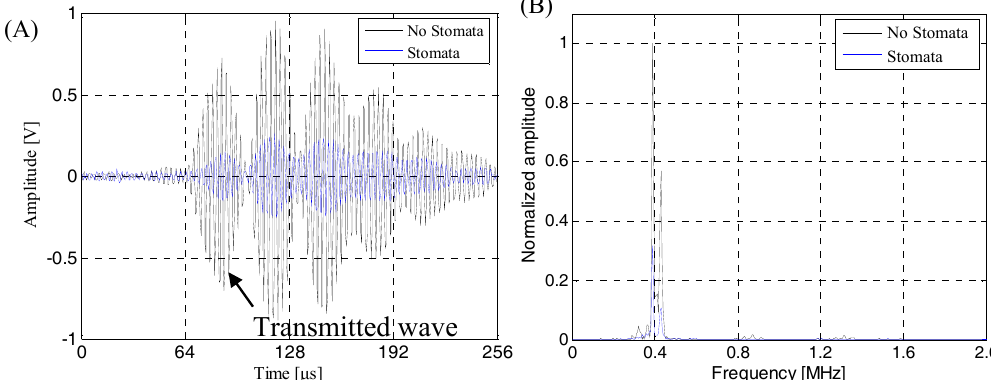
Figure 20. The contrast between the transmission signal of the near-surface stomata defect of a lithium-ion battery and the transmission signal of an intact lithium-ion battery sample. ( A ) The transmission signal; ( B ) The corresponding frequency spectrum.